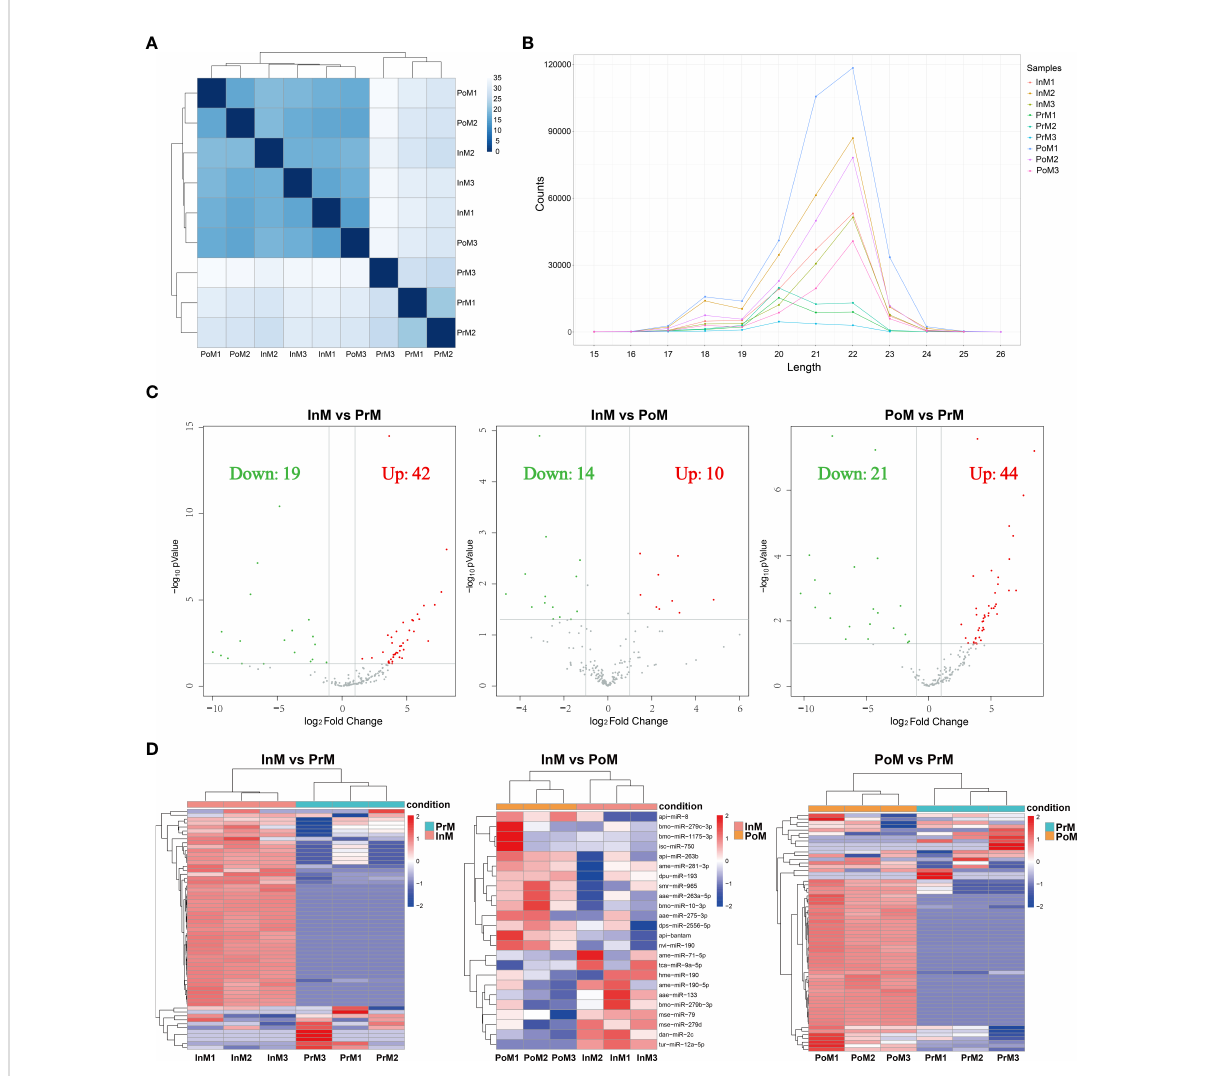
FIGURE 6 Annotation and analysis of mRNAs. (A) The DE miRNAs correlation heatmap of sample clustering. (B) Length distribution of miRNAs. (C) Volcano plot of the DE miRNAs between adjacent molting stages of S. paramamosain. The horizontal axis shows the log 2 Fold change, and the vertical axis represents -log 10 pvalue. The grey color represents the unchanged, red color represents upregulated, and the green color represents the downregulated DE miRNAs. PoM, postmolt; InM, intermolt; PrM, premolt. (D) Heatmap diagram of the DE miRNAs between adjacent molting stages of S. paramamosain . Each row represents one miRNA. The horizontal axis represents the sample clusters. Each column represents one biological replicate. The red and blue segments indicate relatively high and low expression level. PoM, postmolt; InM, intermolt; PrM,